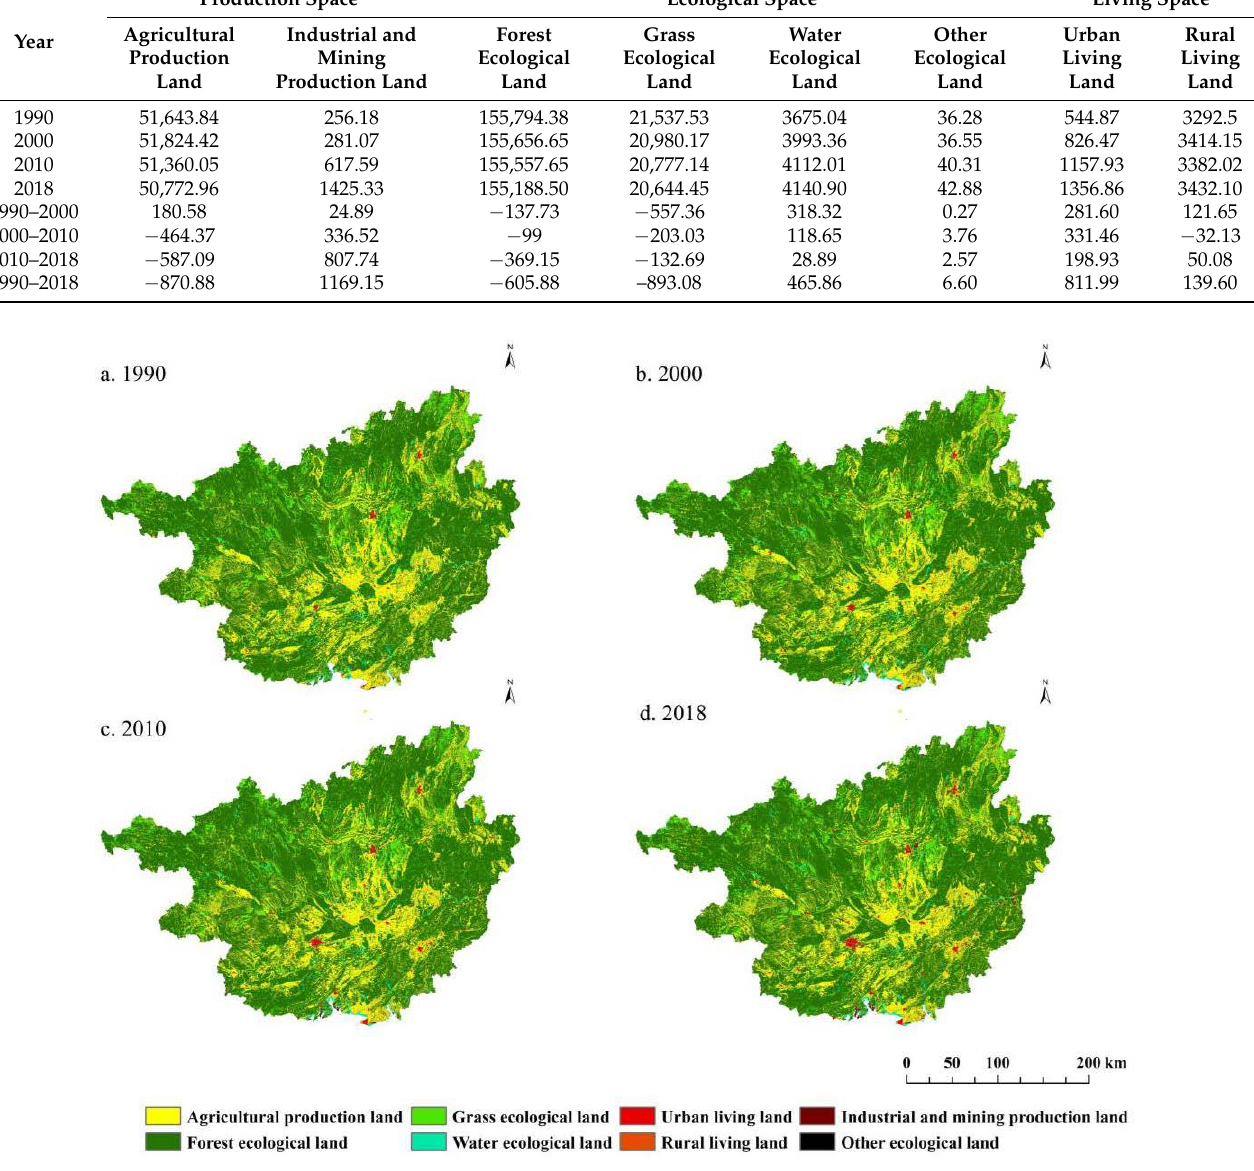
Figure 3. Spatial distribution of PLES in Guangxi, China. In order to find out the direction and quantity of interconversion between different land use types, the land use transfer matrix was obtained by superposition analysis in ArcGIS Pro, based on the land use data of the four time periods (Table 3). During 1990–2018, transfers in and out of agricultural productive land and forest ecological land were quite frequent. The net transfer of grass ecological land to forest ecological land mitigated the latter’s declining trend over time. By contrast, urban living land and industrial and mining production land underwent sharp growth in area, this mainly sourced from the agricultural production land and forest ecological land. In general, under the promotion of industrialization and urbanization, the production space and living space in Guangxi were constantly encroaching upon ecological space. Although various land consolidation